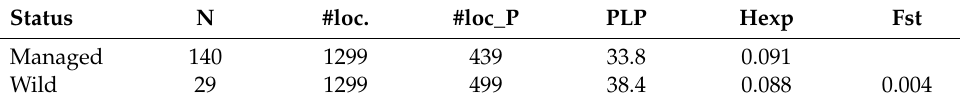
Table 8. Genetic diversity measures of G. kola based on status and growing